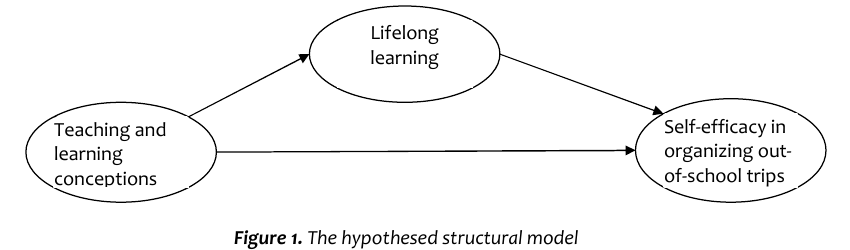
Figure 1. The hypothesed structural